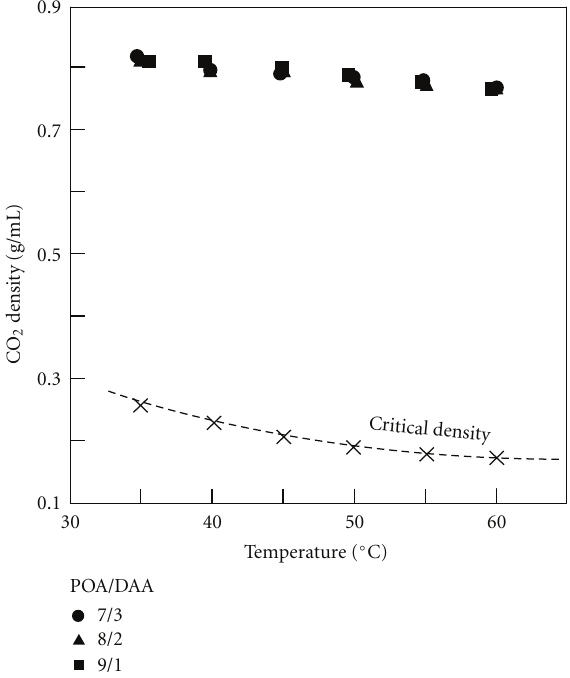
Figure 9: Plots of the experimental cloud points of the copolymers at each temperature versus the CO 2 density.